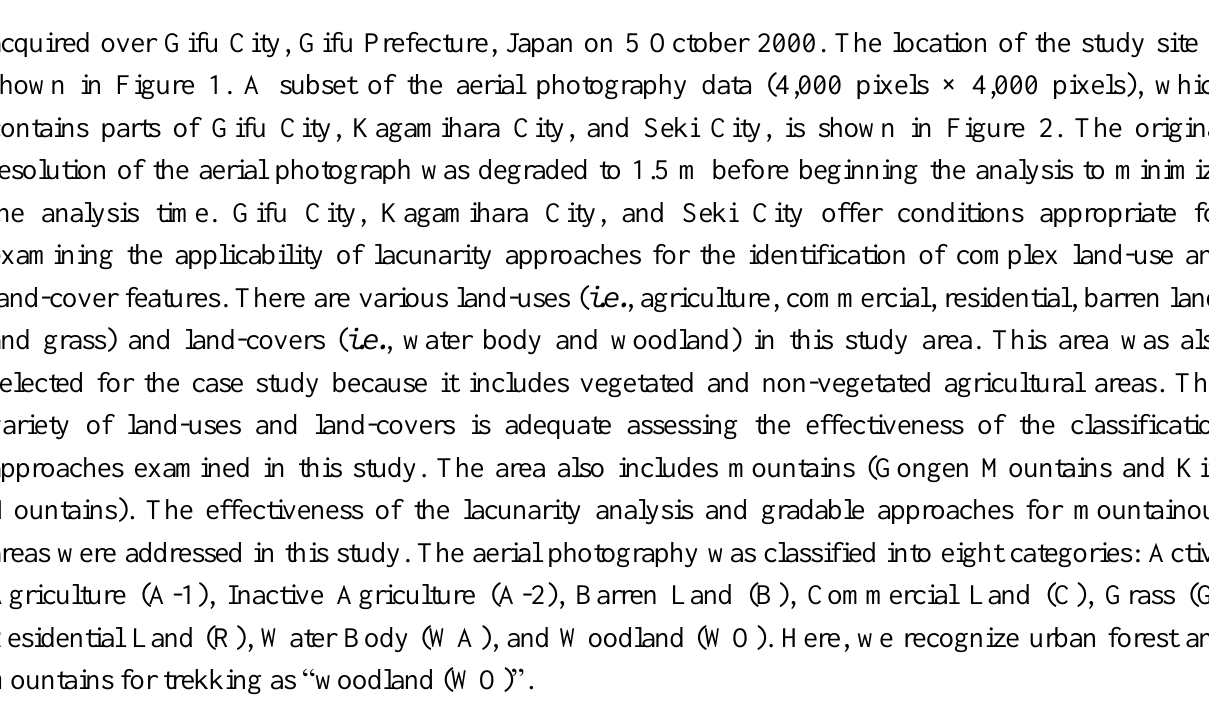
Figure 1. Study area of this